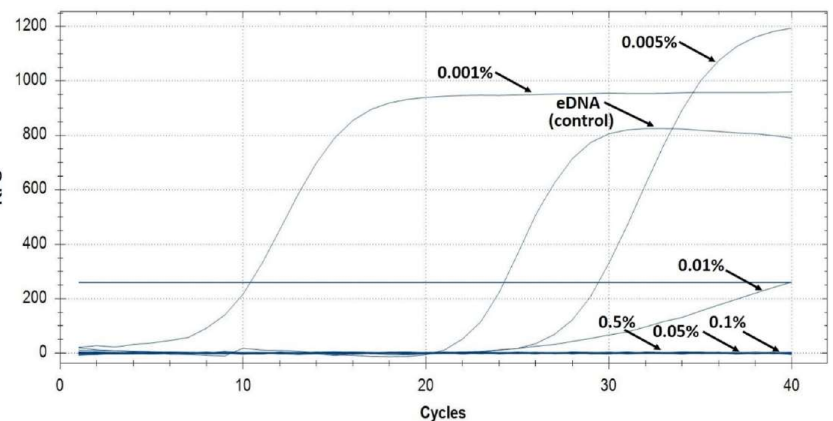
Figure 9. Real-time PCR of a model eARG is inhibited by PHMG-Cl treatment of eDNA. Shown here are the real-time PCR amplification curves of the KPC antibiotic resistance gene from UHI KP 1633 eDNA samples after PHMG-Cl treatment. The water-only control and 0.001–0.5% PHMG-Cl treatments are indicated. Note that RFU is not normalized as quantitative results were not needed and these curves are only used to indicate positive PCR amplification. The blue horizontal line is the fluorescent threshold, and Cq (not marked) is where the PCR amplification curves cross the